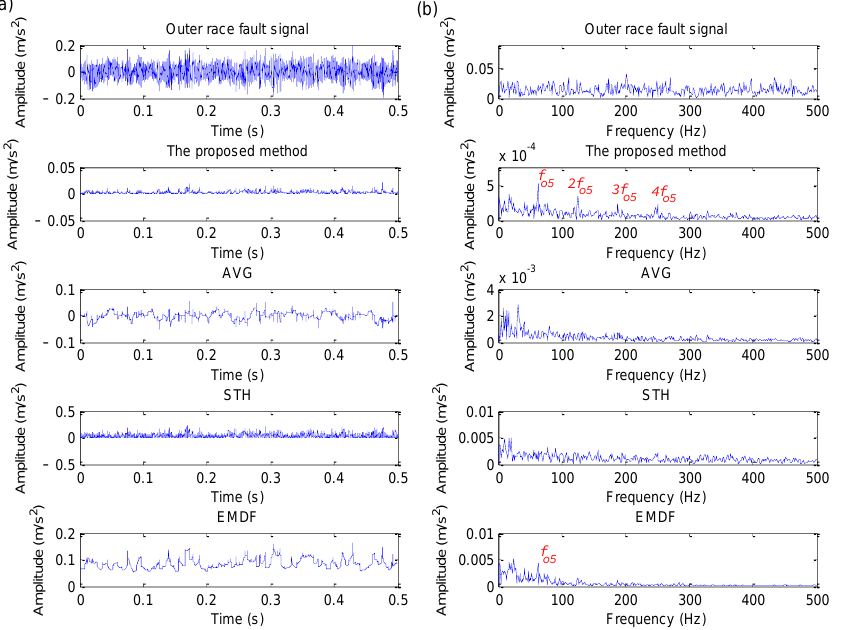
Figure 24. Analysis results obtained by different methods for outer race fault signal in case 3: ( a ) Time domain waveform; ( b ) its corresponding envelope spectrum.